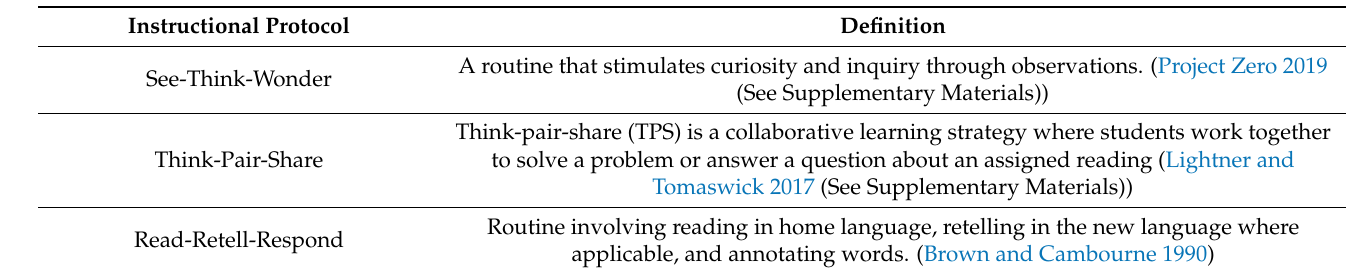
Table 5. Instructional Protocols used in HLA and ELA